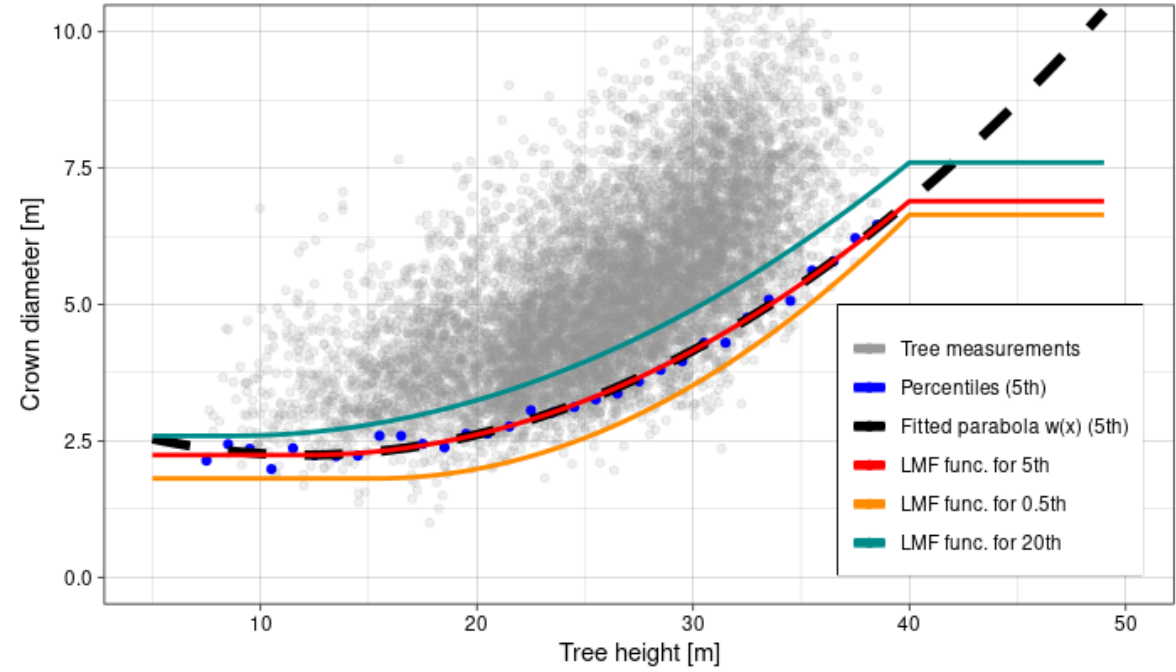
Figure 6. Construction of the Local Maximum Filter (LMF) function of the moving window for the detection of local maxima (percentile p = 5), taking into account the variability of height and crown diameter parameters, determined based on field dendrometric measurements on circular plots. Two more LMF functions provided: for 0.5th percentile and 20th